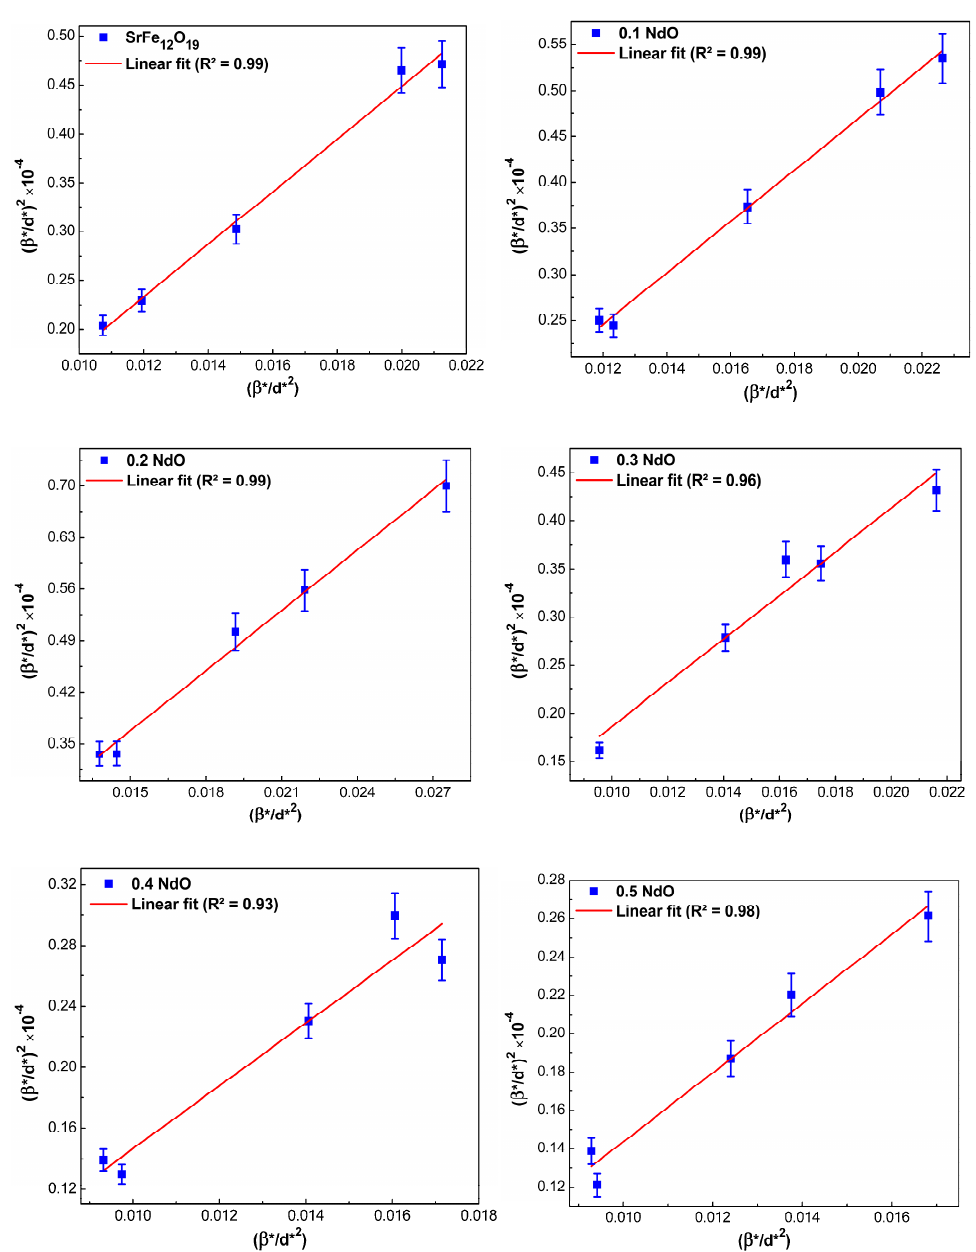
Figure 6. Halder–Wagner plots for hexaferrite powders SrFe 12-x Nd x O 19 (0 ≤ x ≤ 0.5). It turned out that as the Nd-content in SrFe 12-x Nd x O 19 powders increased from x = 0 to x = 0.5, the average size of crystallites increased from 66.5 to 99.5 nm. At the same time,